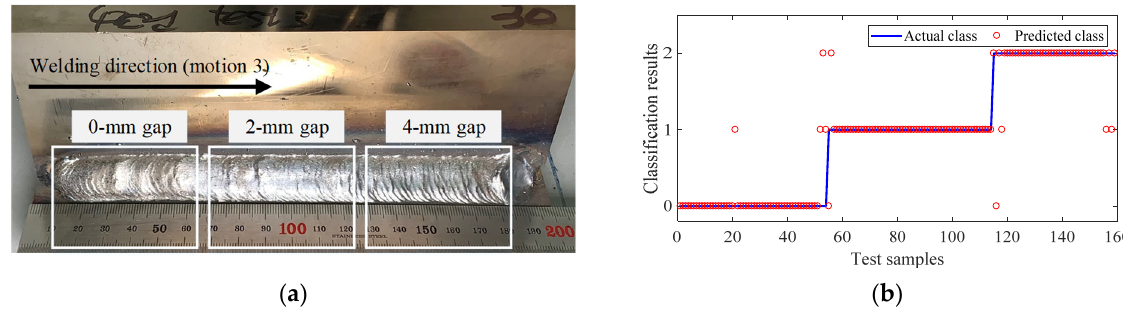
Figure 12. Offline verification results for optimal conditions for 4 mm gap (applied robot motion 3): ( a ) weld bead shape of each weld gap region and ( b ) weld gap classification results.